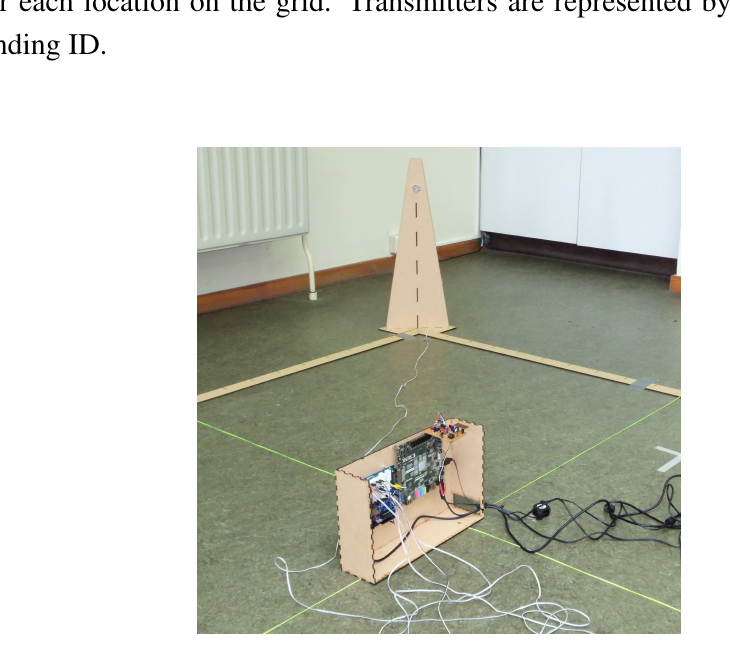
Figure 19. Test setup of the indoor localization implementation showing the receiver and one transmitter in one corner of the